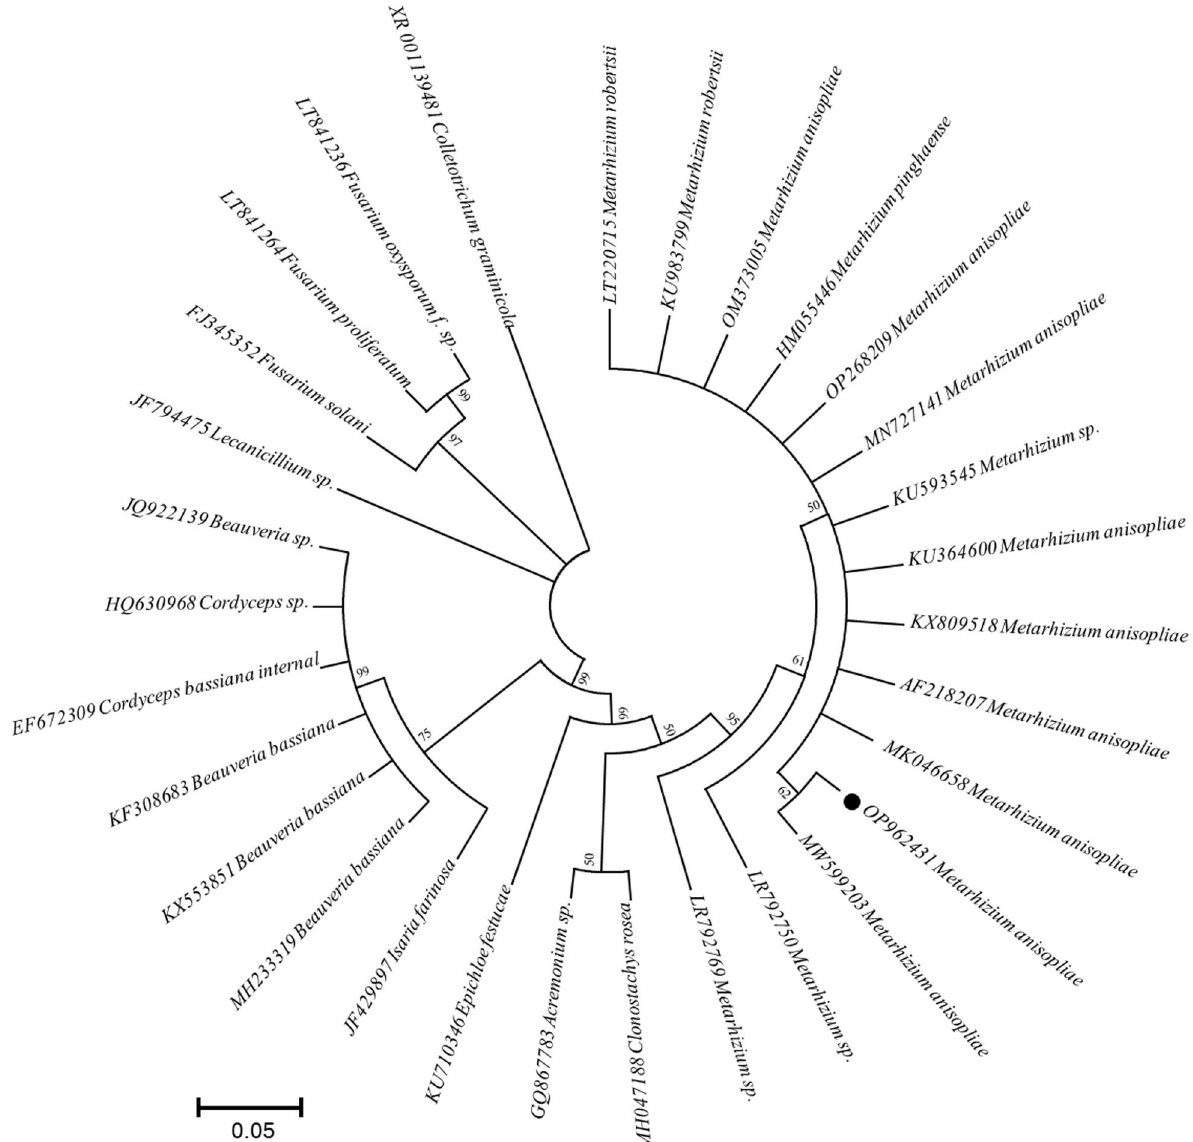
Fig. 1 Molecular phylogenetic analysis by maximum likelihood method based on the Jukes–Cantor model. The percentage of trees in which the associated taxa clustered together is shown next to the branches. Initial tree(s) for the heuristic search were obtained automatically by applying the Maximum Parsimony method. The tree is drawn to scale, with branch lengths measured in the number of substitutions per site. Evolutionary analyses were conducted in MEGA